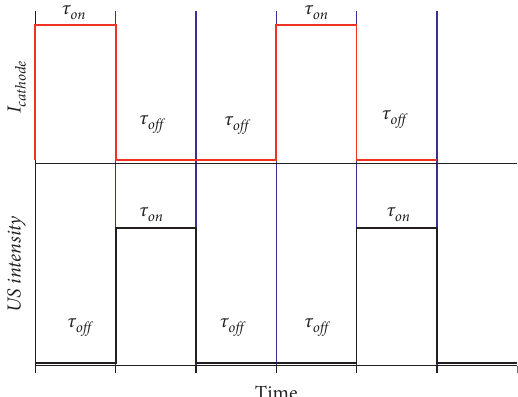
Figure 4: Scheme of pulsed current supply and ultrasound during sonoelectrochemical synthesis of MNPs.